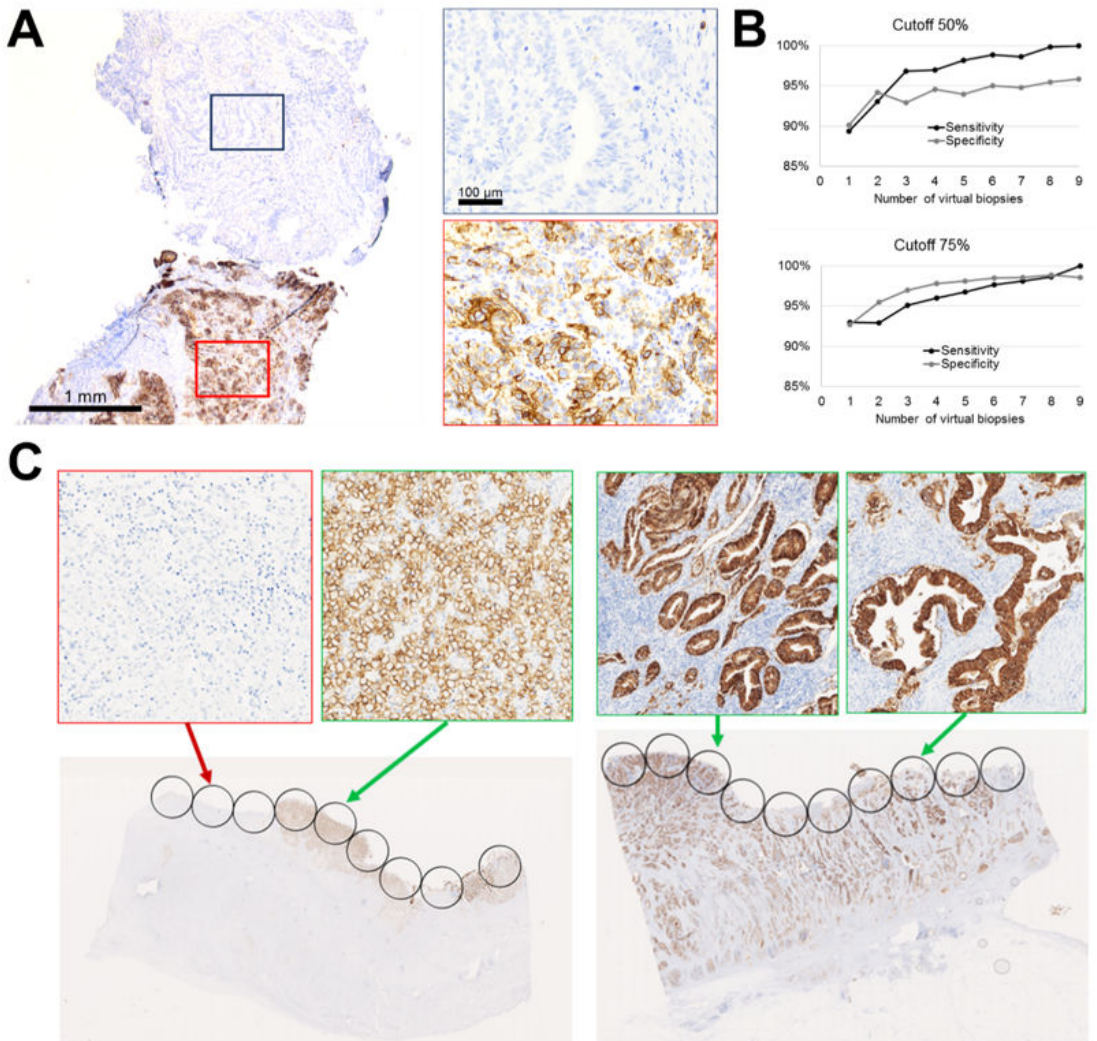
Figure 1. ( A ) Representative example of intratumor CLDN18 heterogeneity; two biopsies from the same primary cancer show dissimilar CLDN18 status. ( B ) Sensitivity and specificity of CLDN18 testing according to the number of virtual biopsies scored. ( C ) Two examples of a heterogeneous CLDN18 tumor (left panel) and a gastric adenocarcinoma with a homogeneous CLDN18 status in all the analyzed areas. The selected virtual biopsy area was drawn on the luminal part of the sample, thus simulating superficial biopsy samples obtained at endoscopy. (Original magnifications 1 × , 5 × and 20 ×